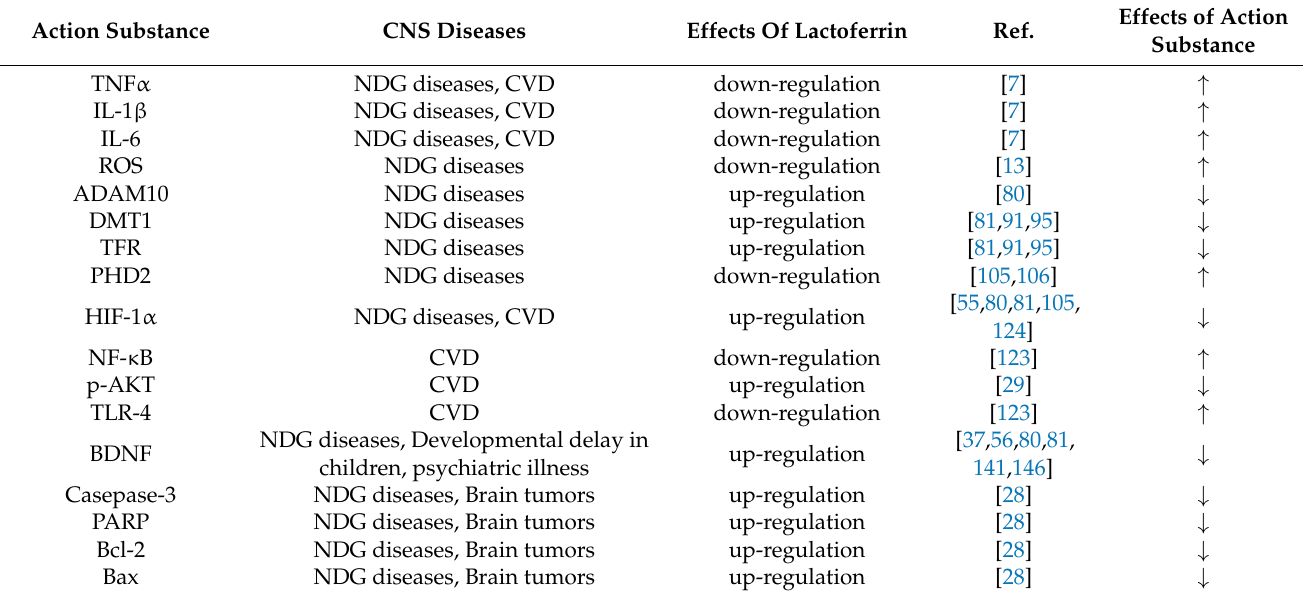
Table 1. The active substance of lactoferrin and its role in CNS